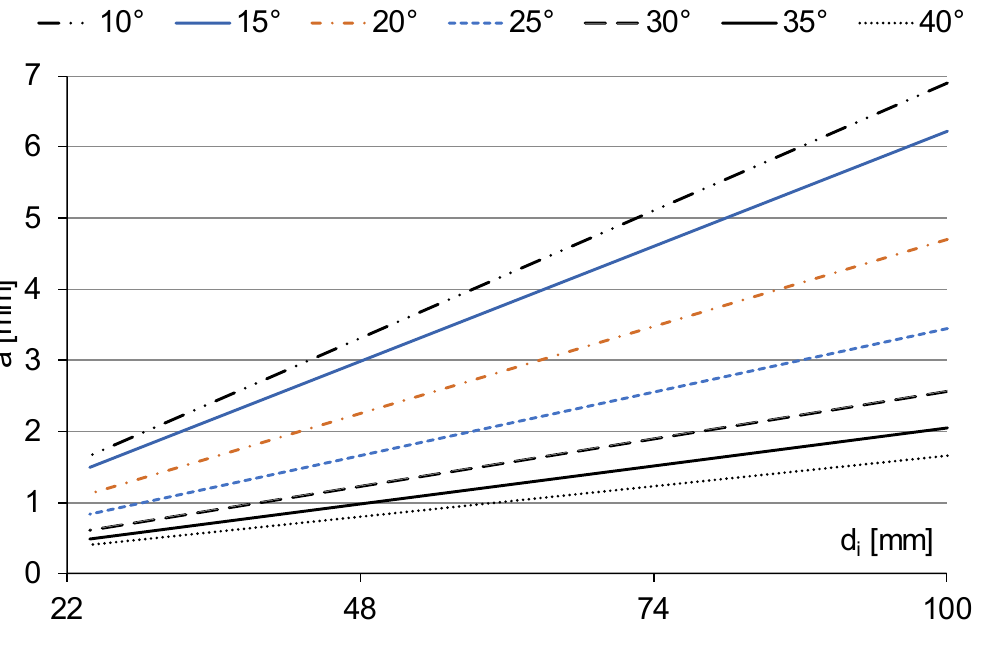
Figure 6: Determining the optimal dimensions of a stamp width for different internal friction angles r using the method of characteristics and the linear Coulomb condition for the laboratory